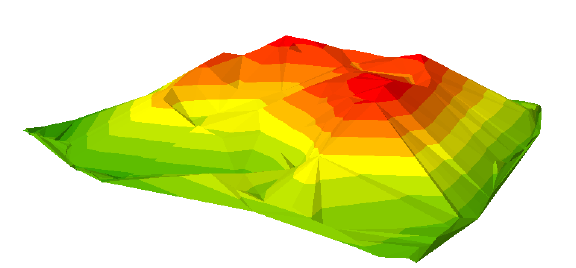
Figure 3. TIN Surface from TST data 3D view